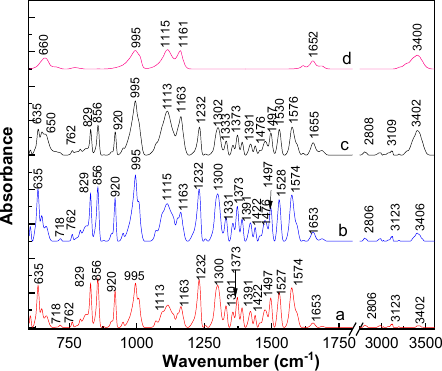
Figure 4. IR spectra of the ST-reacted AZA samples with ST concentrations in the reaction mixture of 25 wt.% ( a ), 50 wt.% ( b ) and 75 wt.% ( c ), as well as ST ( d ).